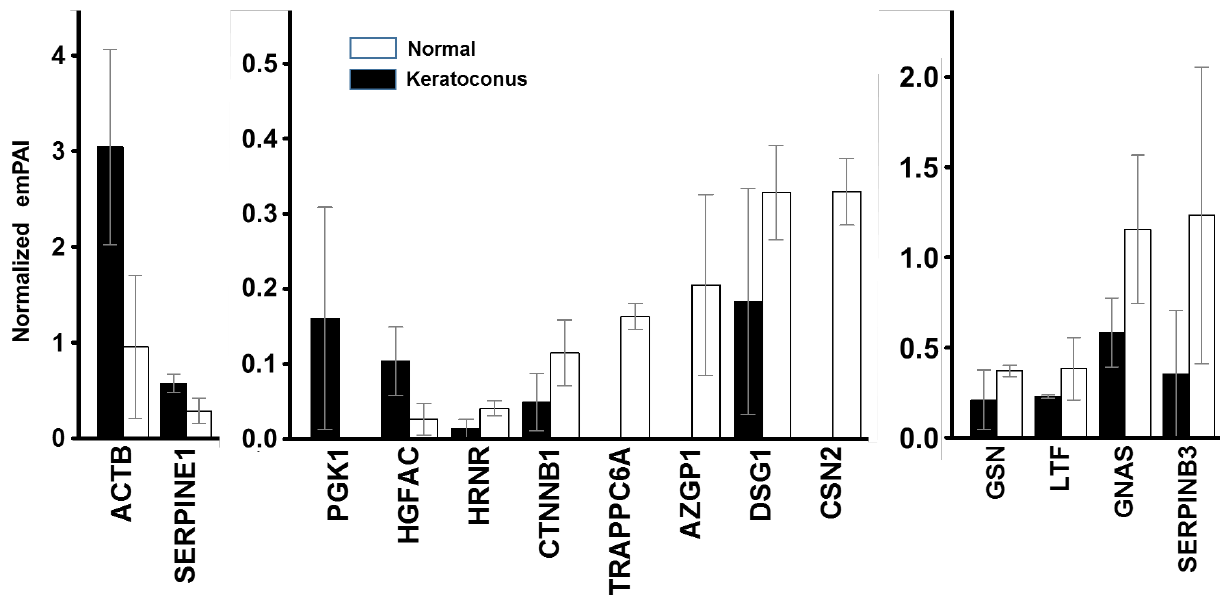
Figure 2. Proteins whose relative abundance levels in exosomes produced by stromal cells from healthy corneas and from KC show statistically significant differences (Mann-Whitney U test). The normalized emPAI values for healthy corneas (white bars) and KC (black bars) are shown. The spreads represent standard deviation.